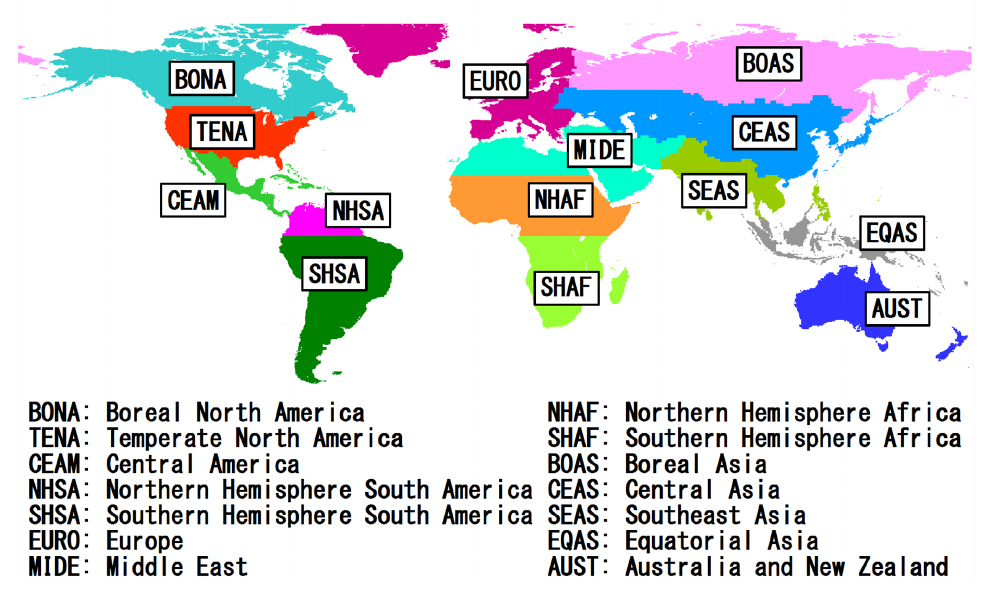
Figure A1. Map of the 14 global regions derived from Giglio et al. (2006) and van der Werf et al. (2017).